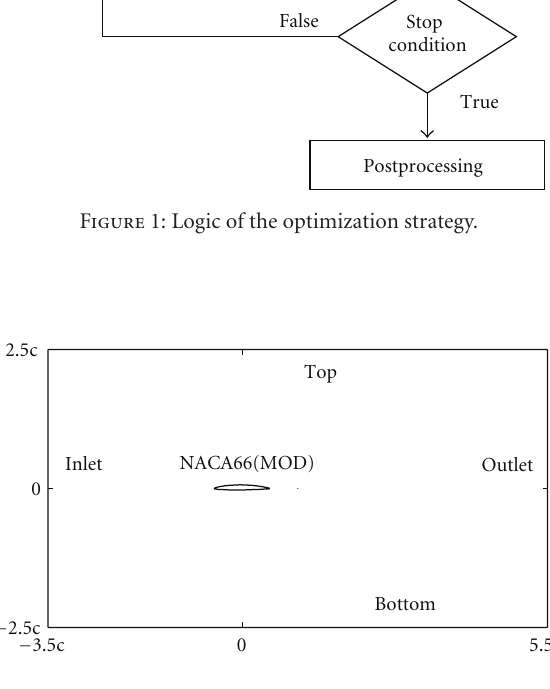
Figure 2: NACA66(MOD), shape of the computational domain.